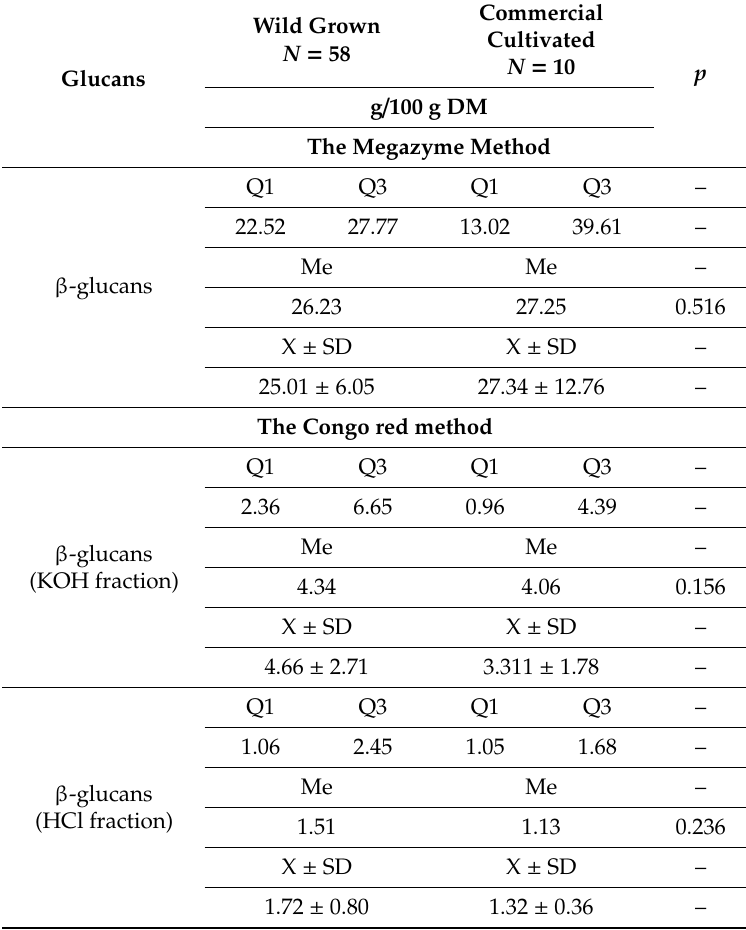
Table 3. β -Glucans content in wild mushrooms vs. commercial